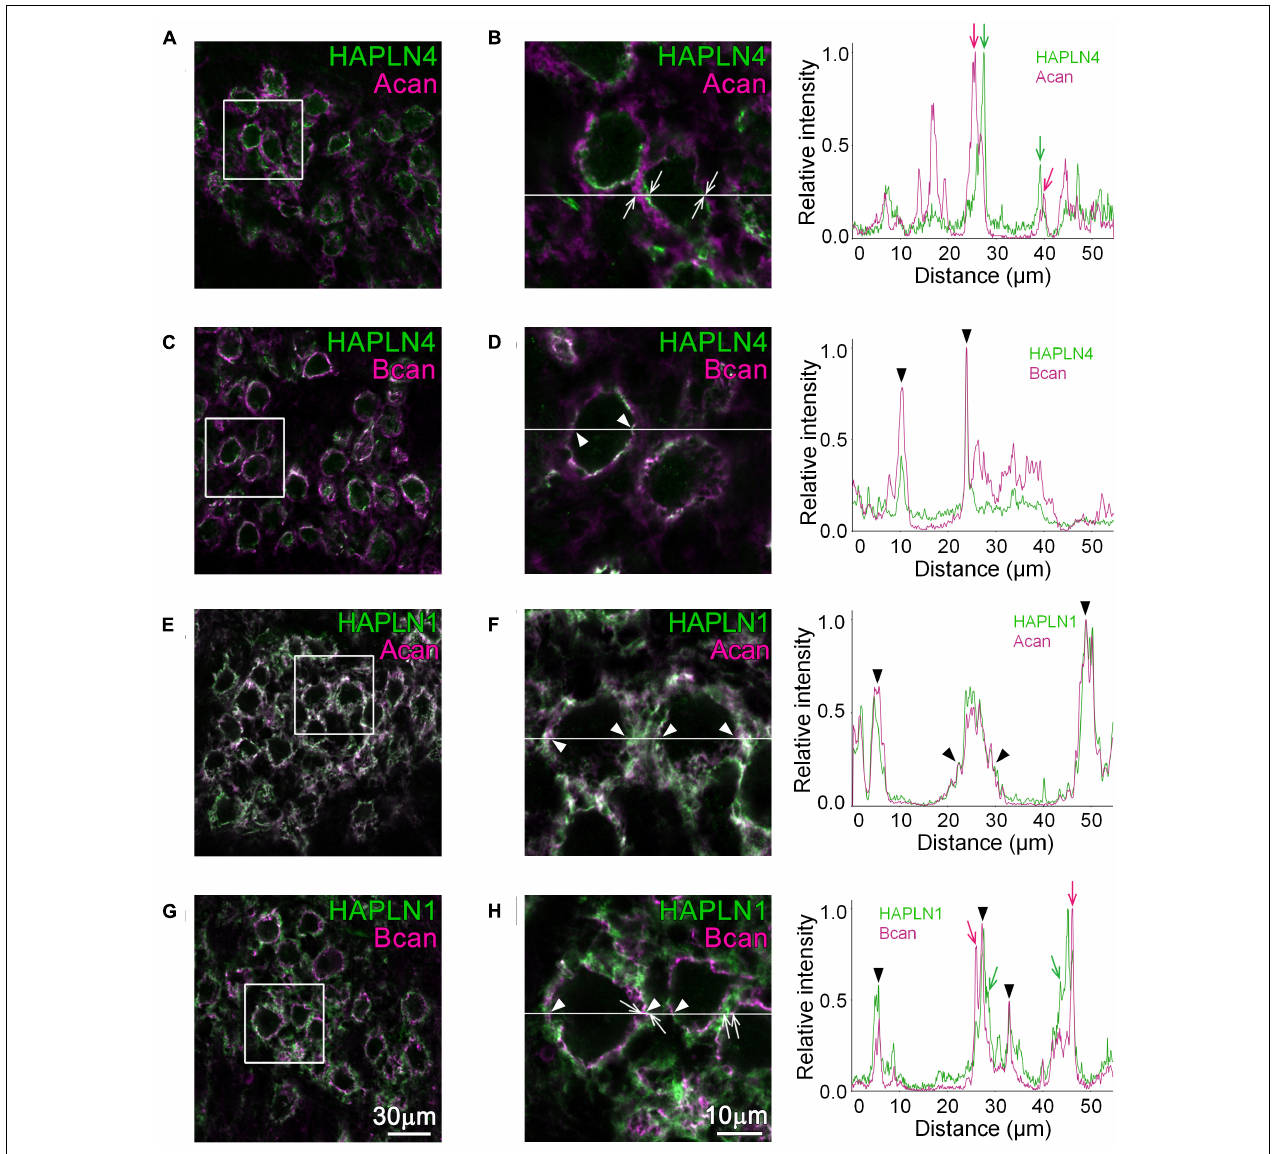
FIGURE 1 | Distribution of HAPLNs and lecticans in the medial nucleus of the trapezoid body (MNTB) of adult wild-type (WT) mice. Immunohistochemical detection of HAPLNs (green) and lecticans (magenta) in the MNTB of 4-month-old adult WT mice using HAPLN4 (A–D) , HAPLN1 (E–H) , aggrecan (A,B,E,F) , and brevican (C,D,G,H) immunostaining. The intensity profiles of the fluorescence signals along the white lines are shown in the rightmost panels. The fluorescence intensities are normalized by the highest intensities of individual proteins within the lines. Of note are the well-segregated signals between HAPLNs and CSPGs that are indicated by arrows (HAPLNs in green and CSPGs in magenta, respectively). The colocalized signals are indicated by arrowheads. Acan, aggrecan; Bcan, brevican. Scale bar = 30 µ m in the left panels and 10 µ m in the right